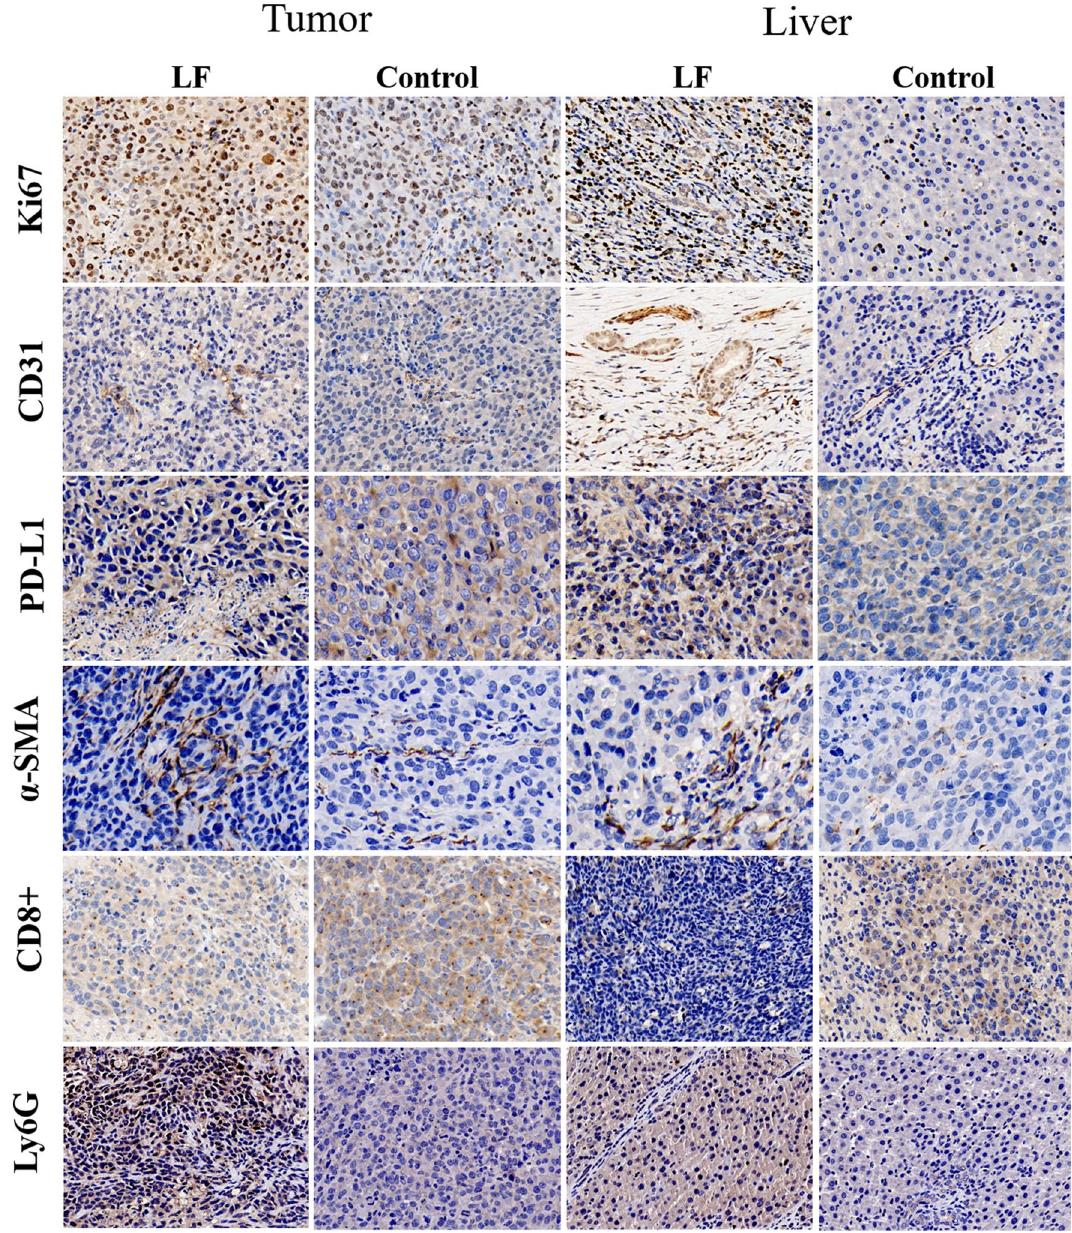
Figure 2. Representative pictures of IHC staining of tumor and liver in LF group and control group